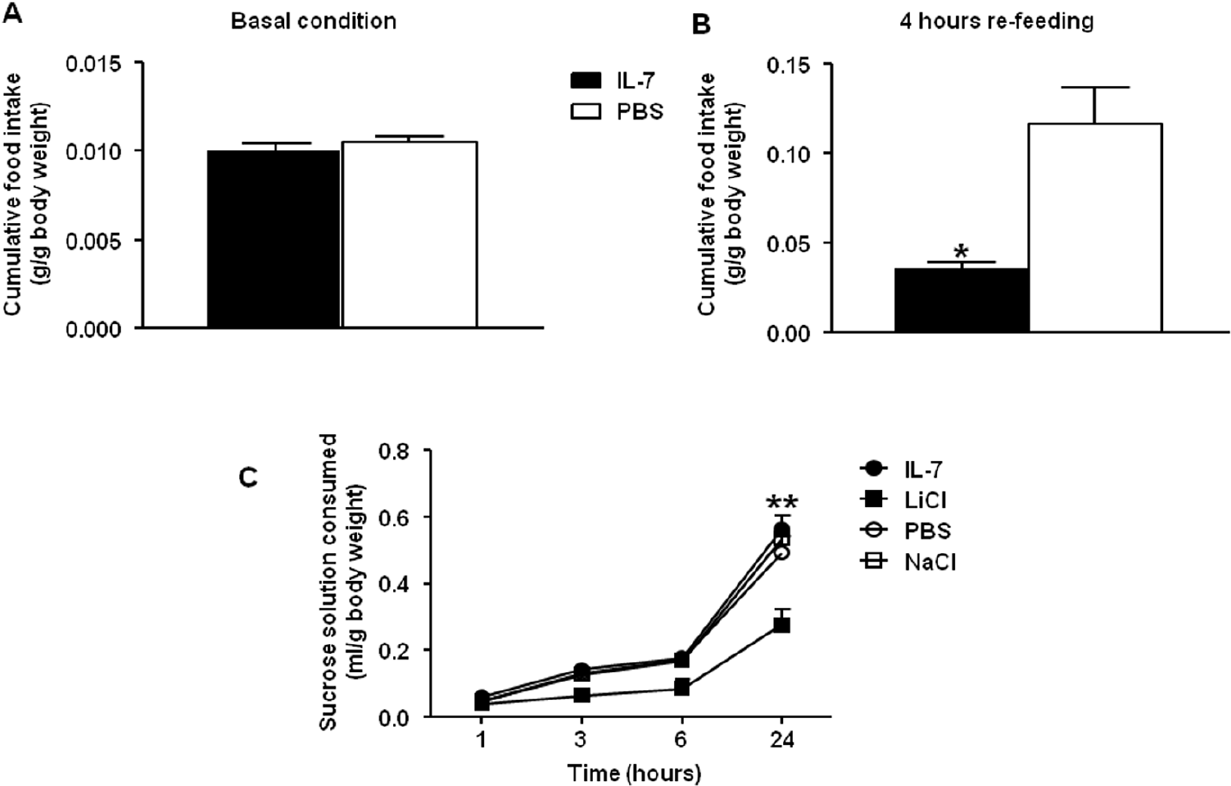
Figure 5. IL-7 regulates food intake after fasting. ( A ) Food intake during basal conditions in IL-7- ( & ) or PBS- ( % ) treated C57BL/6 mice (n=7 per group). Results are expressed as the mean 6 SEM of cumulative food intake in g/g of body weight. ( B ) Animals were overnight-fasted, treated with IL-7 ( & ) or PBS ( % ) before getting free access to food (n=5 per group). Food intake was measured during the 5 h following re-access to food and was expressed as mean 6 SEM of cumulative food intake in g/g of body weight. * p , 0.05. ( C ) Prior to the taste aversion assay, water was N removed from animal cages overnight. Taste solution of 5% sucrose was offered for 30 min and mice were either s.c. injected with 0.3 m g of IL-7 ) or PBS as control (n=4, # ), or i.p. injected with 6 mEq of LiCl (n=5, & ) or NaCl as control (n=4, % ). After injection, animals got free access to (n=5, water containing 0.5% of sucrose. Sucrose cumulative consumption was individually measured 1 h, 3 h, 6 h and 24 h after injection. Results are expressed as mean of sucrose consumption in ml/body weight in g 6 SEM. * p ,